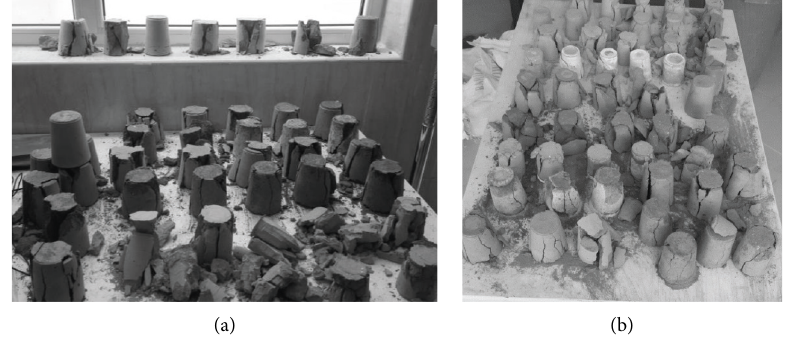
Figure 12: Examples used in laboratory studies.